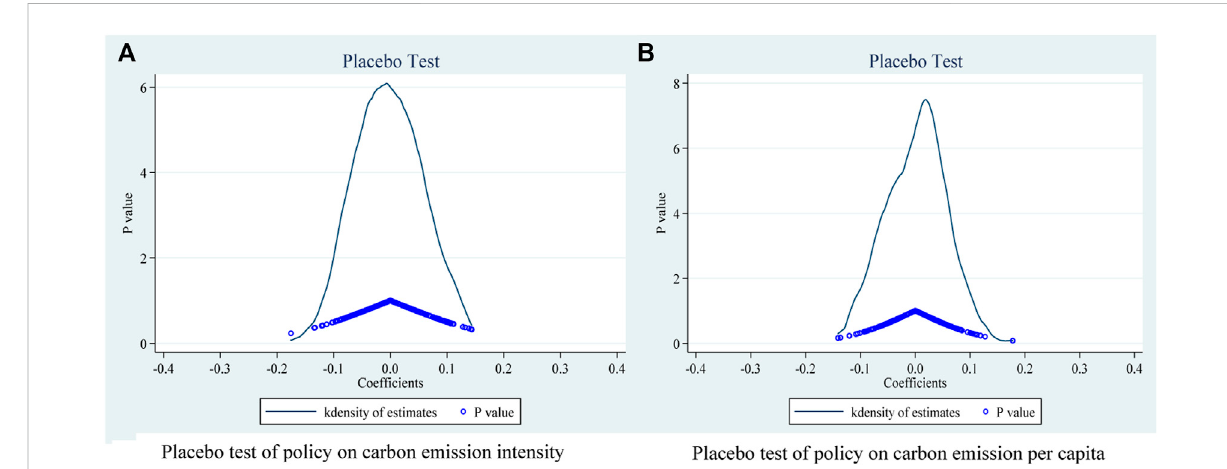
FIGURE 2 The results of the placebo test. (A) Placebo test of policy on carbon emission intensity. (B) Placebo test of policy on carbon emission per